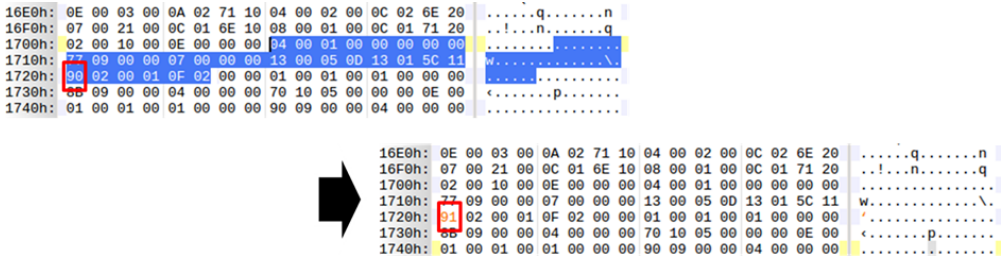
Figure 28. Dalvik bytecode partial